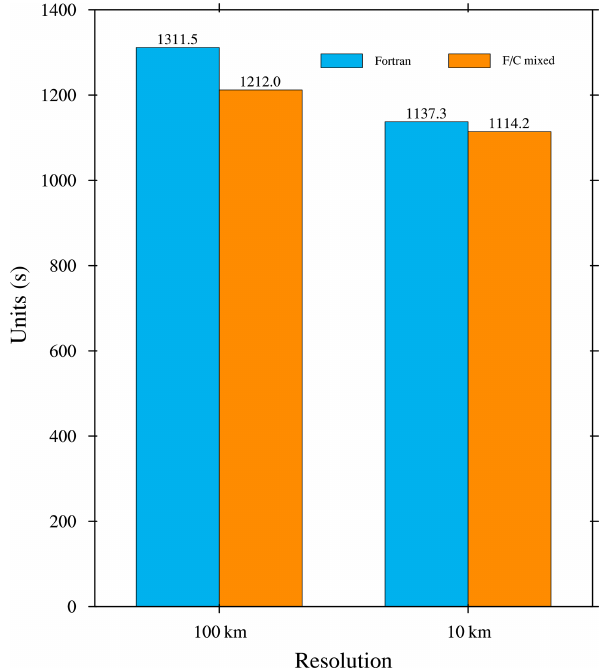
Figure 3. The wall clock time of a model day for the 10km version and a model month for the 100km version. The blue and orange bars are for the Fortran and Fortran and C mixed versions. These tests were conducted on an Intel Xeon CPU platform (E5-2697A v4, 2.60GHz). We used 28 and 280 cores for the low and high resolu- tions,